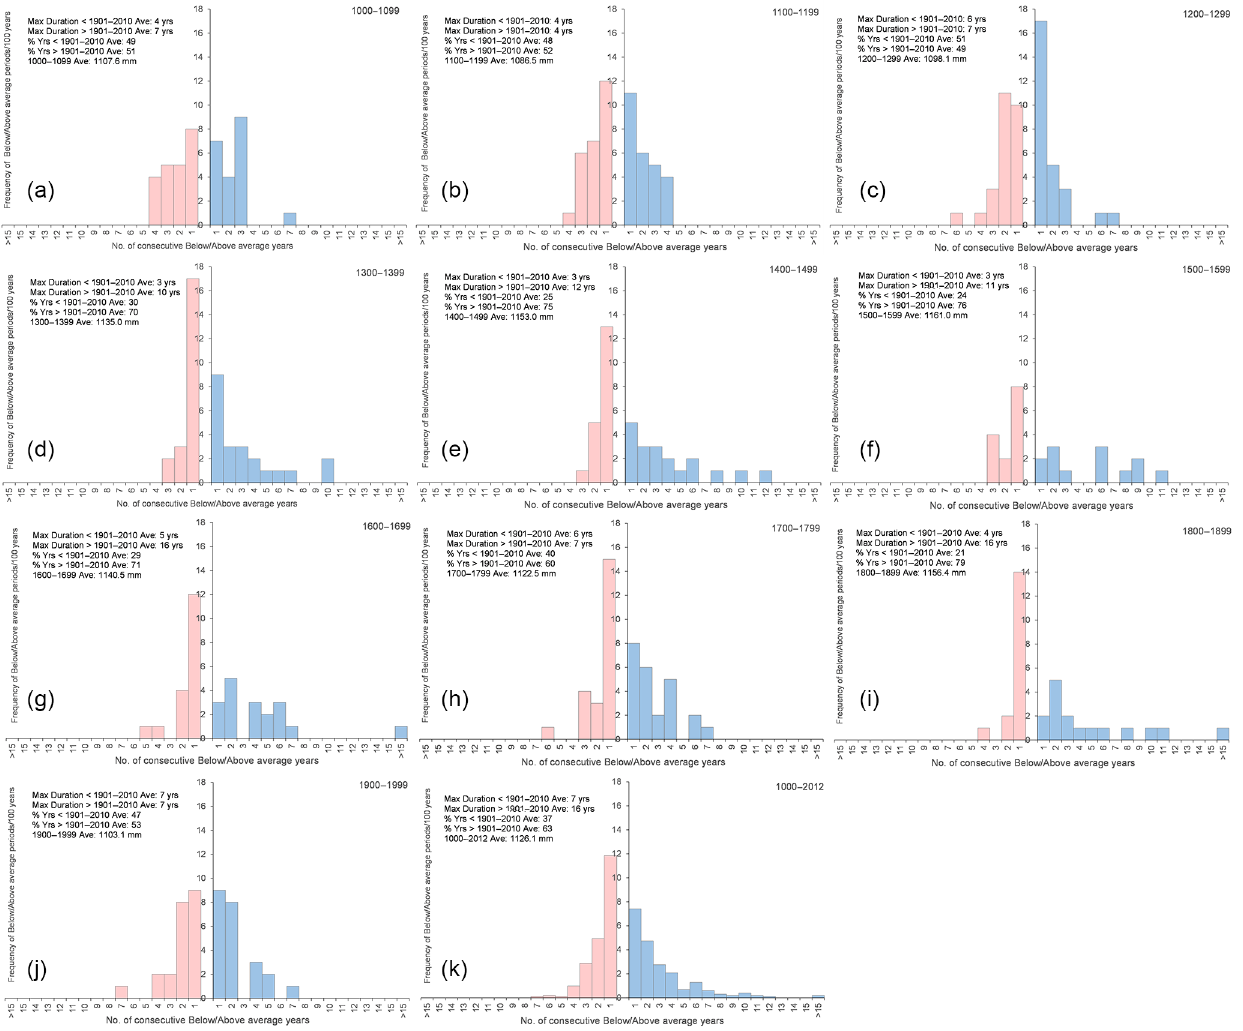
Figure 6. Histograms of duration of above (blue) and below (pink) average rainfall periods in each century since CE1000. (a) – (j) are centennial subsets and (k) is the CE1000–2012 period (note different axis scaling). Above/below average are defined using x = 0 in Eq. (1) (as per Table